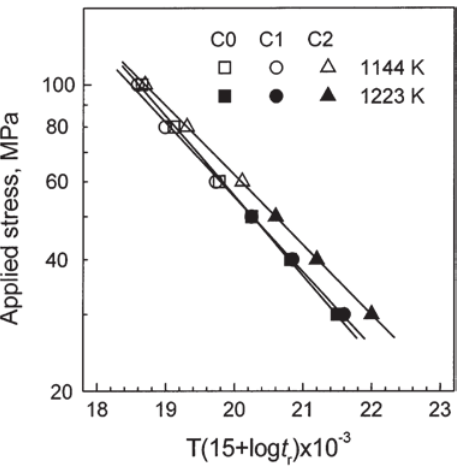
Fig. 5: Larson-Miller rupture curves for the centrifugally cast 25Cr20Ni heat-resistant steel tubes